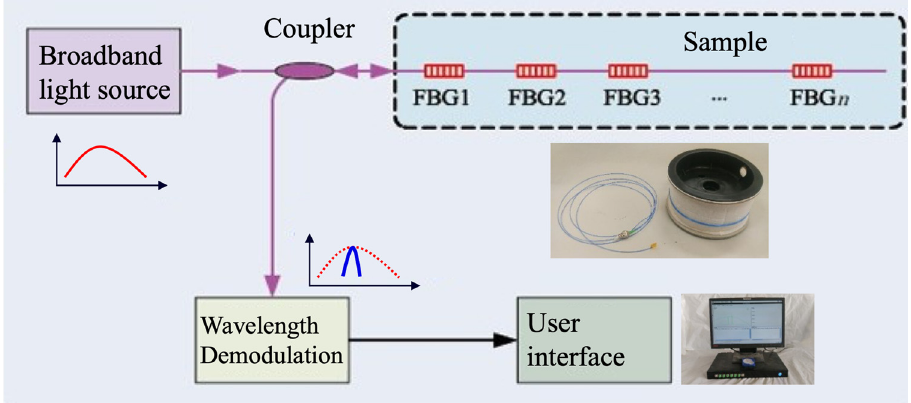
Figure 3. FBG for strain monitoring.